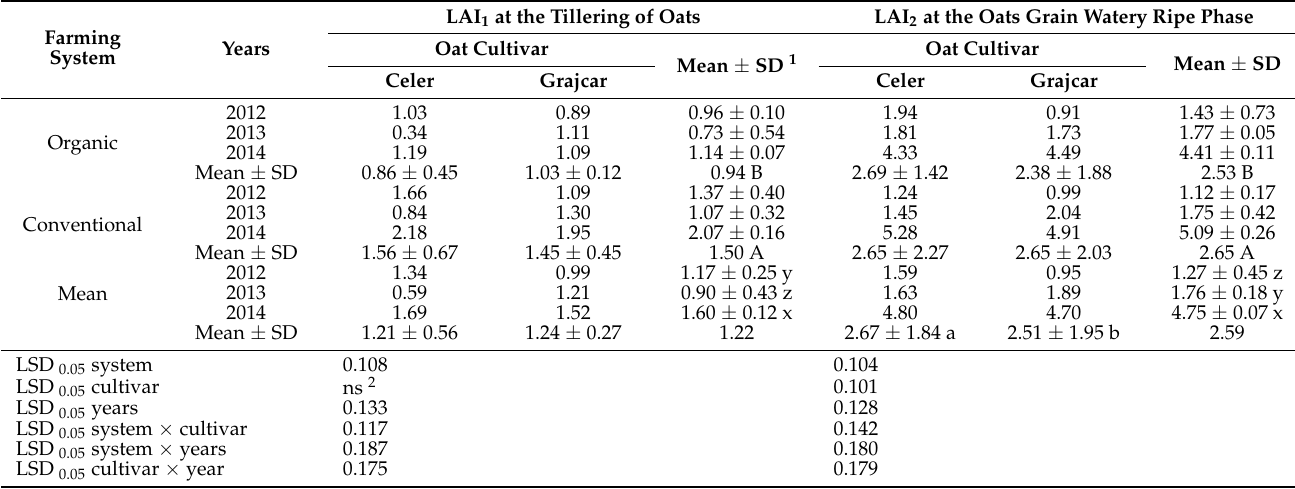
Table 1. Leaf area index (m 2 m − 2 ) of the oat-vetch mixture, measured at the oats tillering: LAI 1 and the grain watery ripe phase; LAI 2 for the farming system in 2012–2014.